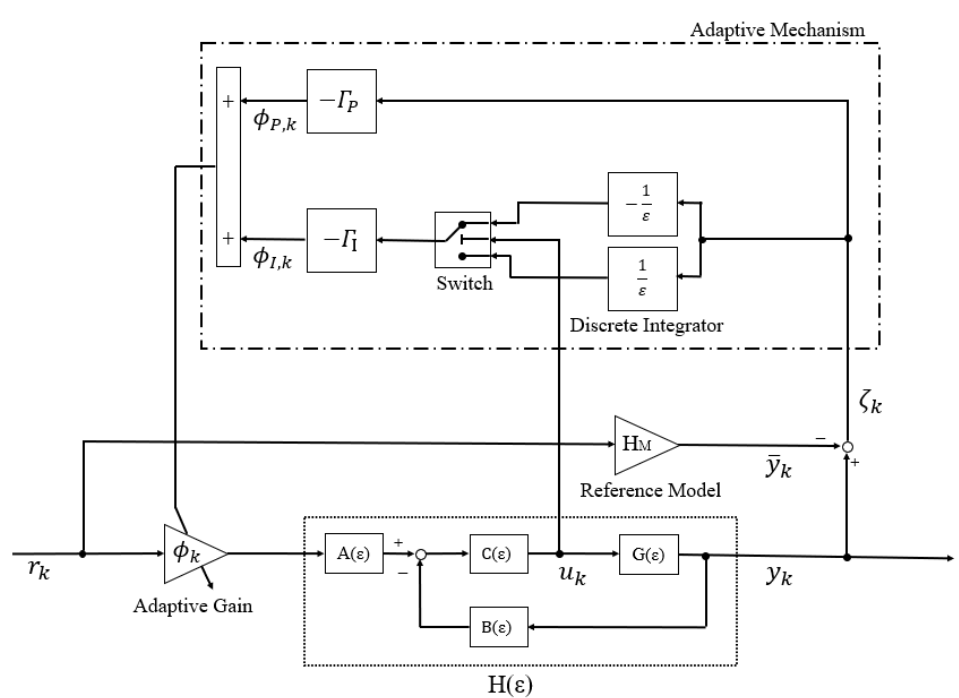
Figure 7. Structure of the proposed